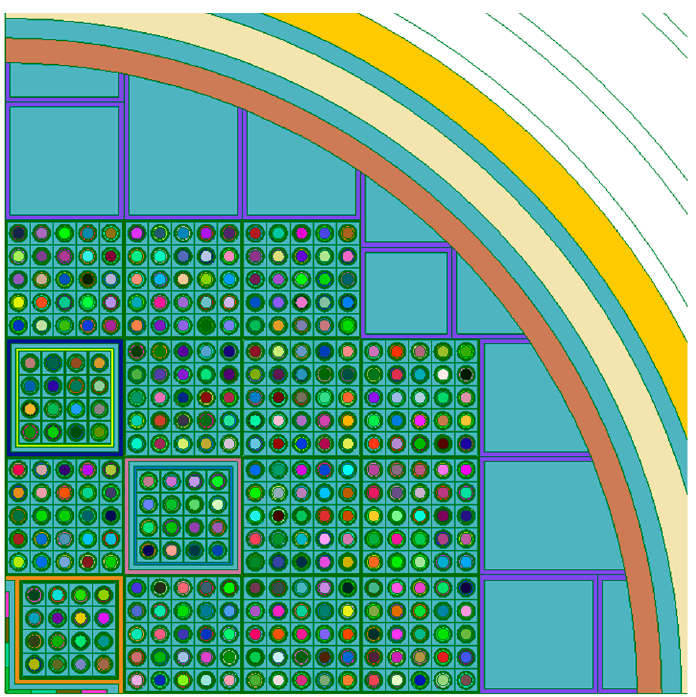
Figure 6. Jules Horowitz Research Reactor radial cut and unit cell by ALAMOS.